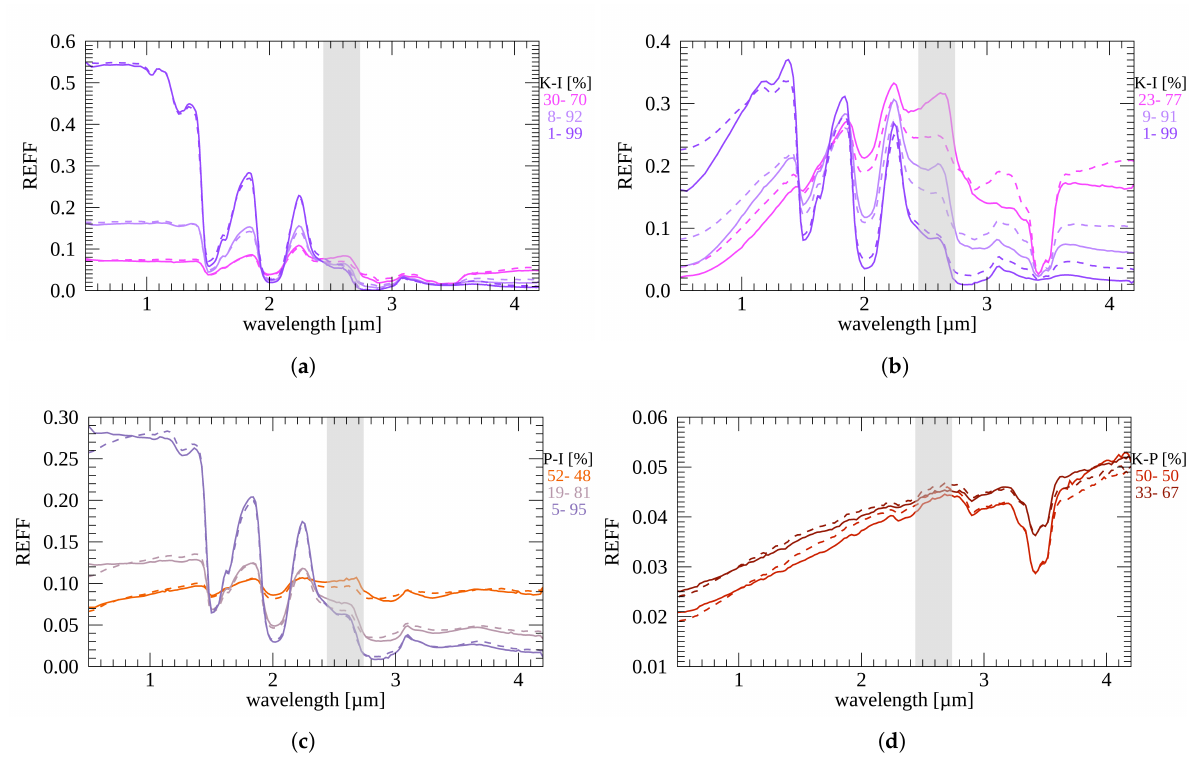
Figure 10. Modelled (dashed lines) and measured (solid lines) spectra for ( a ) water ice–kerite 45–63 ( b ), water ice–kerite < 25 ( c ), water ice–pyrrhotite 25–50 , and ( d ) kerite 25–50 –pyrrhotite < 25 mixtures. The nominal mass fractions of the different endmembers (water ice: I; kerite: K; pyrrhotite: P) are indicated in each panel. The light grey bands indicate a spectral region where possible residual water vapour contamination in the optical path may affect the resulting spectra. Table 1. Intimate mixture modelling parameters: the nominal mass fractions are compared with the fit-estimated values (in parentheses). The resulting values of the scaling factor C are reported, along with the NRMSD and the adjusted grain sizes d ∗ of the indicated endmembers (see text). For the kerite 25–50 –pyrrhotite < 25 mixtures, the kerite/pyrrhotite adjusted size ratio d ∗ / d ∗ p is k